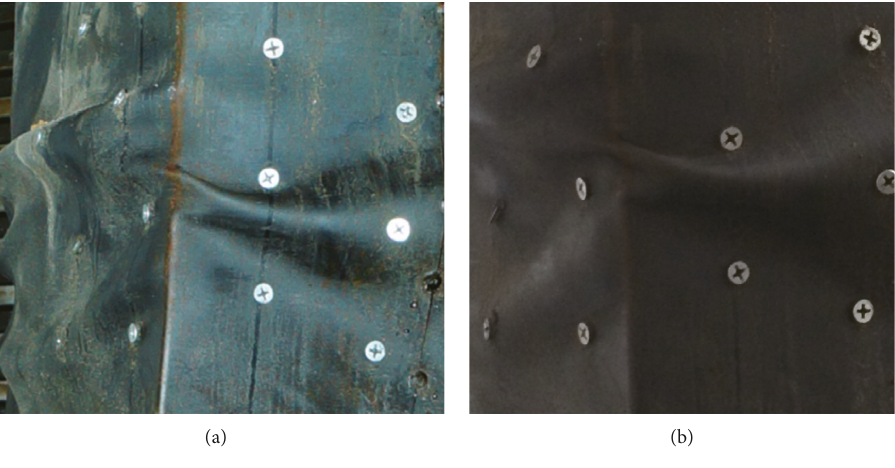
Figure 17: Collapse modes of steel corner